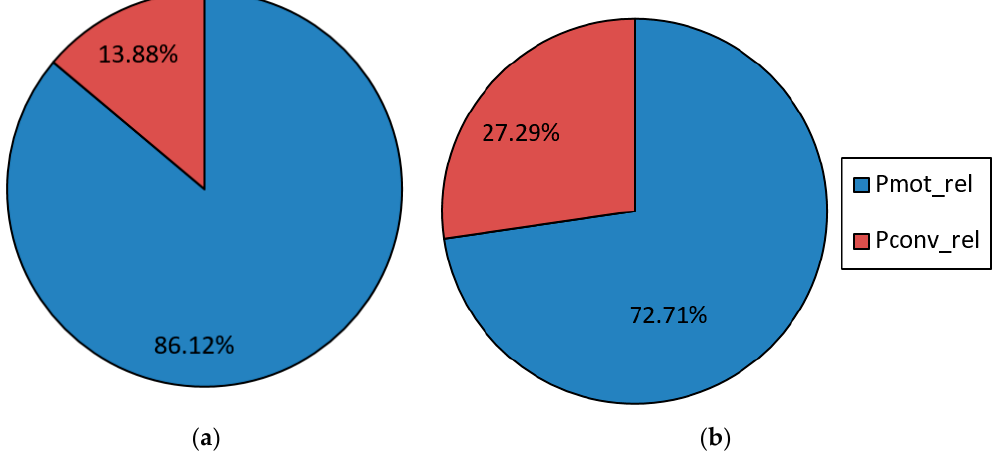
Figure 16. Loss components in mode 4: ( a ) IM drive; ( b ) SynRM drive.